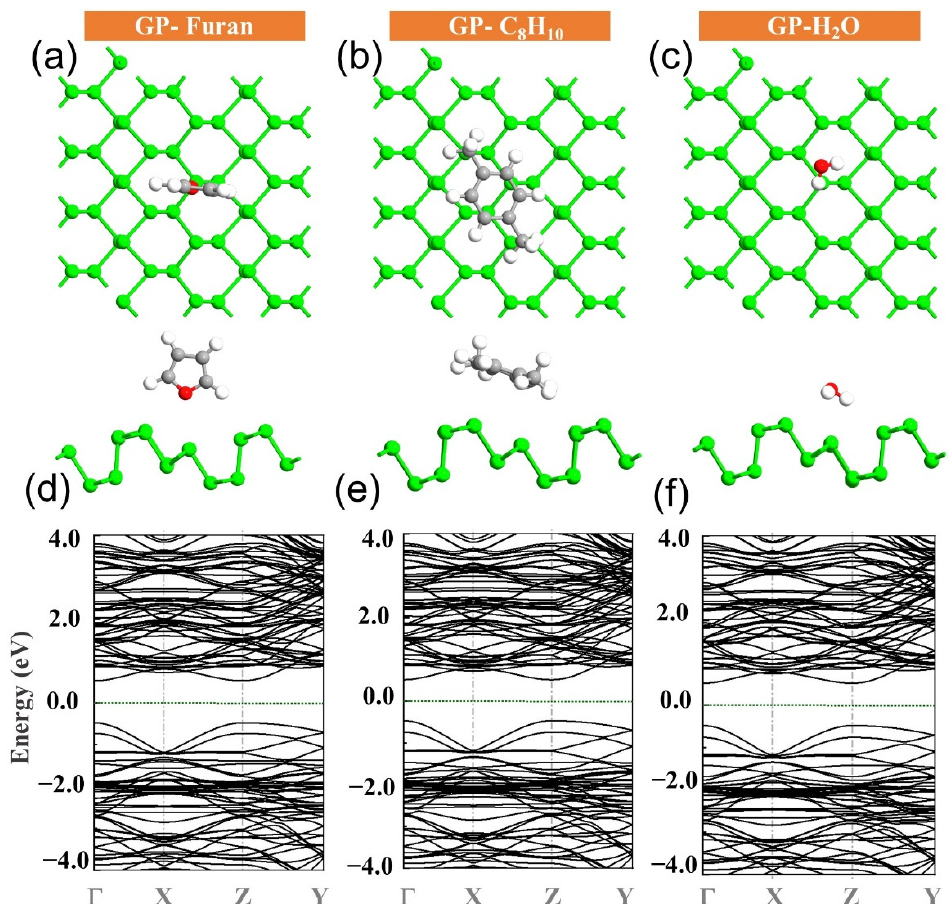
Figure 3. The most stable structures of ( a ) GP-furan, ( b ) GP-C 8 H 10 , and ( c ) GP-H 2 O with their corresponding band structures ( d – f ).